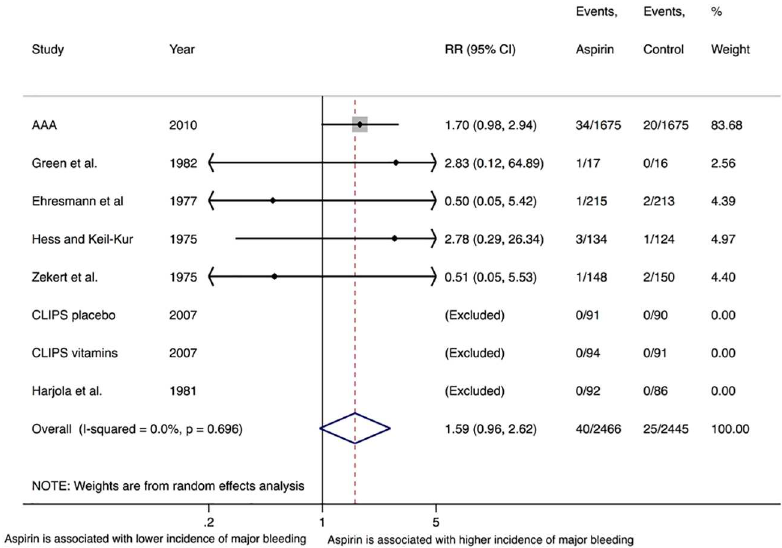
AAA (RR = 1.12, 95% CI 0.32–3.83, P = 0.87, I 2 = 0%) and limited to placebo-controlled trials only (RR = 1.59, 95% CI 0.96–2.62, P = 0.07, I 2 = 0%) yielded the same results. Other subgroup